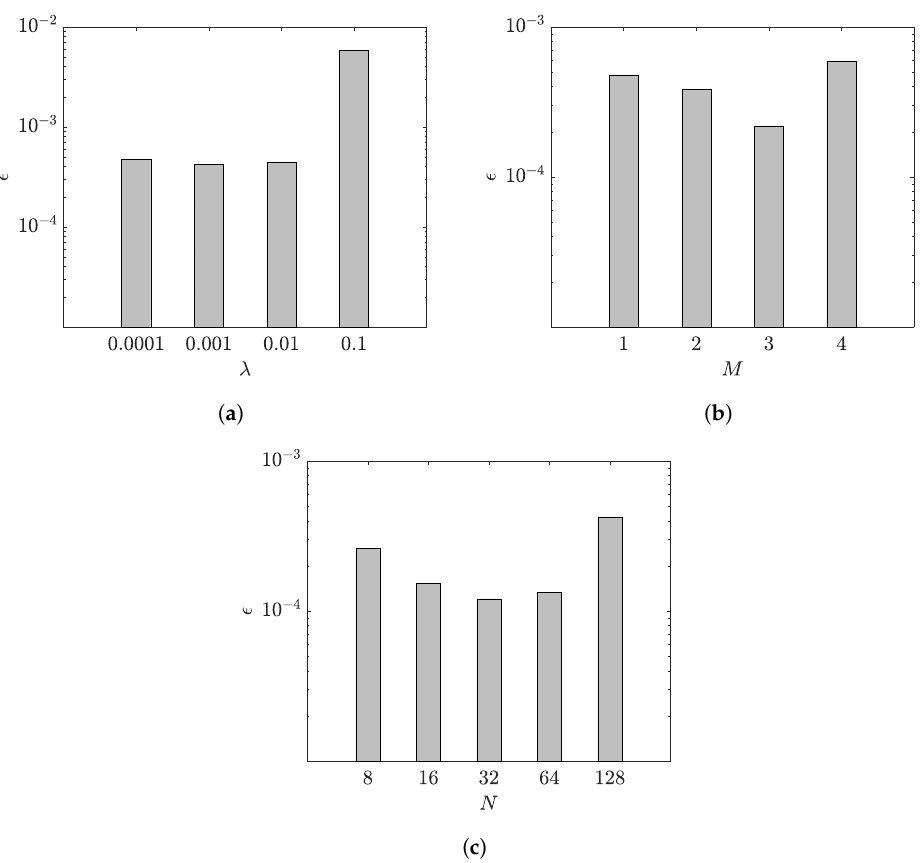
Figure 12. The influence of the ANN-related parameters on its prediction accuracy. ( a ) Regularization constant, ( b ) number of hidden layers, and ( c ) number of neurons.